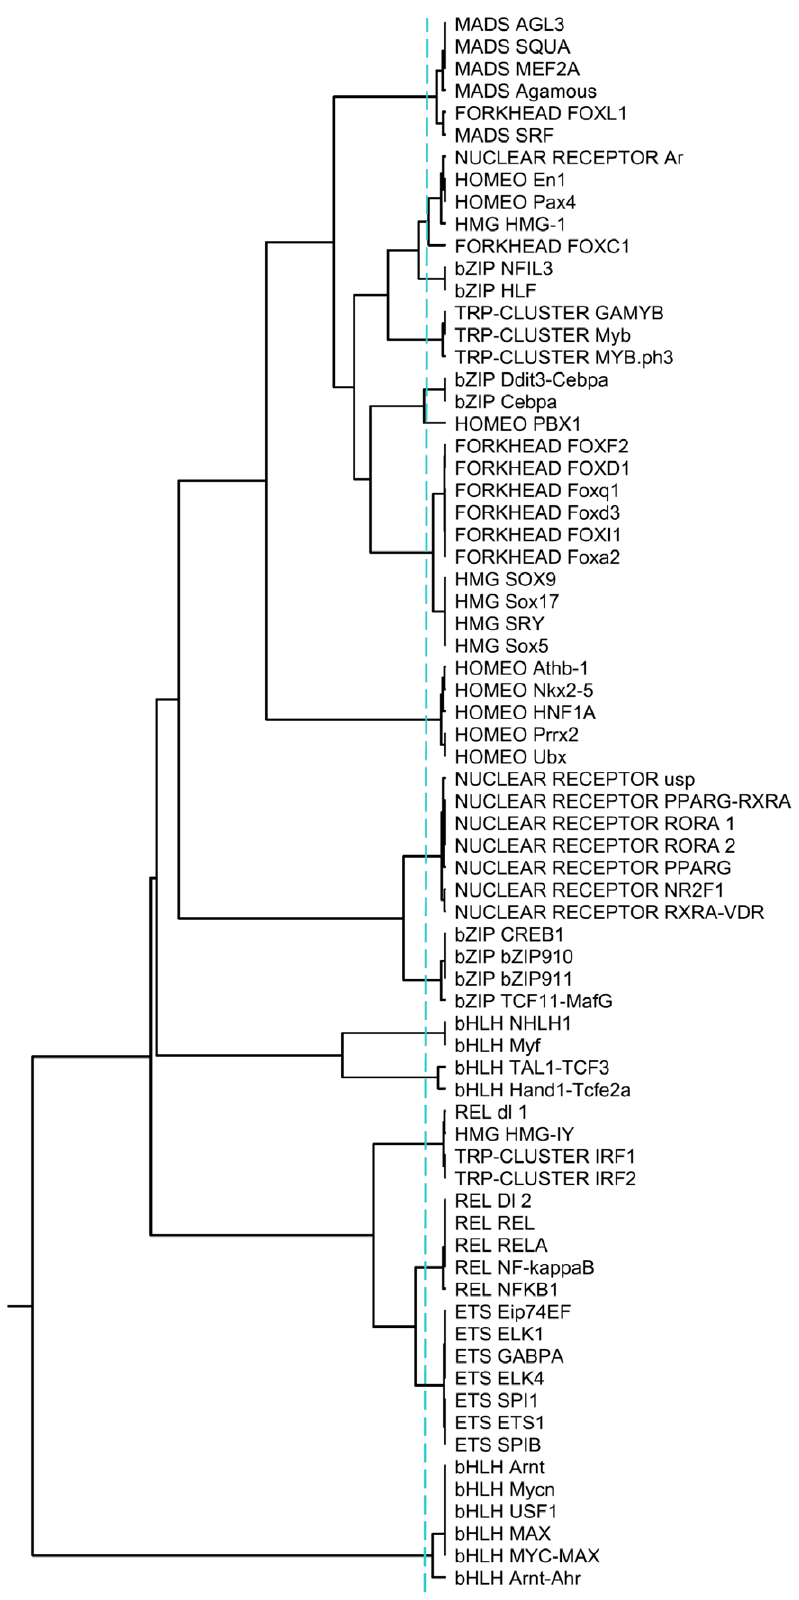
Figure 2. The motif tree of the 71 non-ZF PFMs in Dataset-1. The tree was constructed using the UPGMA algorithm based on the pairwise distances calculated by our KFV method with k =4 and cosine angle metric. The vertical dashed blue line represents the level at which the CH log metric estimates the optimal number of clusters. The 71 PFMs were grouped into 16 groups as indicated by the dashed line.